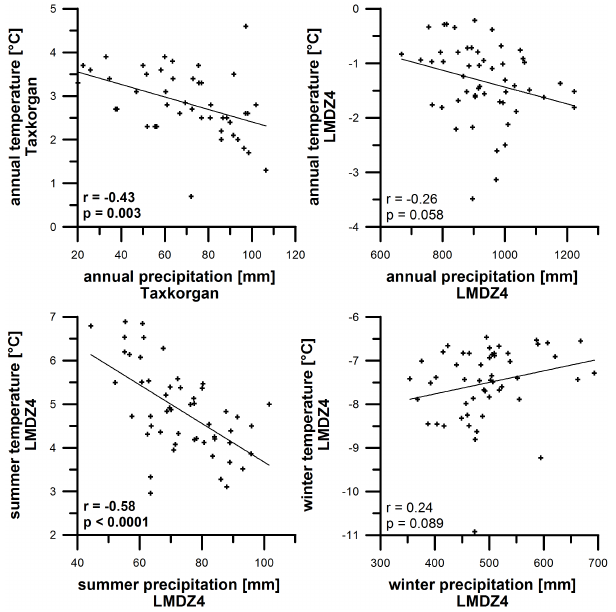
Figure 5. Correlations of temperatures with precipitation amounts based on instrumental data from Taxkorgan meteorological station (1957–2000; annual averages) and model data using LMDZ4 simu- lations (1958–2009; summer: April–September; winter: October– March). Bold correlation coefficients are significant at the 0.01 level.